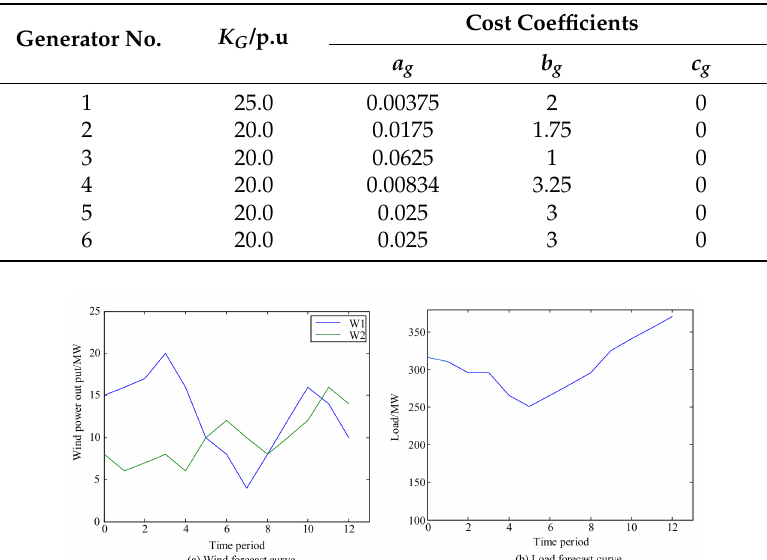
Table 1. Frequency regulation constant and cost coefficients of generators.